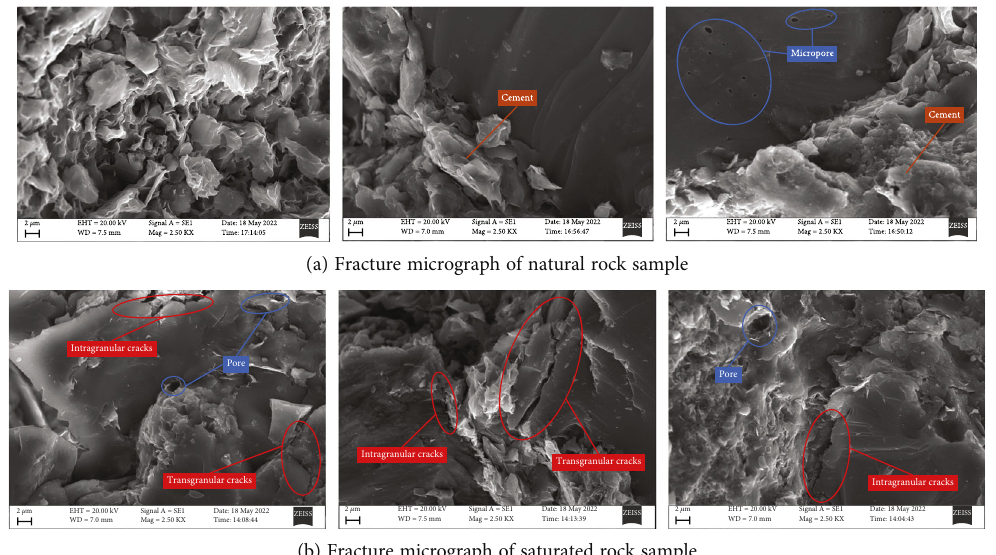
Figure 10: Typical microstructure of argillaceous siltstone